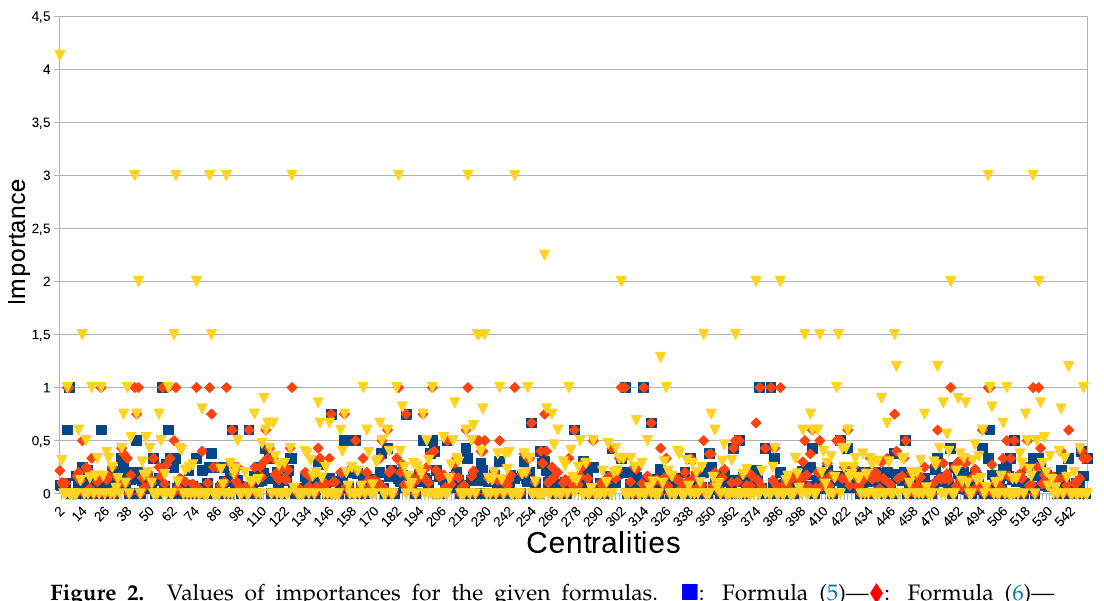
Figure 2. Values of importances for the given formulas. (cid:4) : Formula (5)— (cid:7) : Formula (6)— (cid:72) : Formula